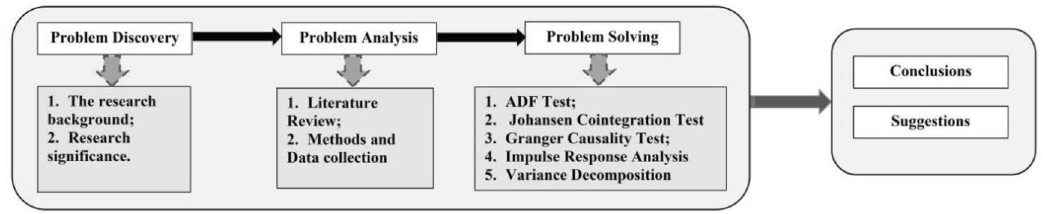
Figure 1. Research Path and